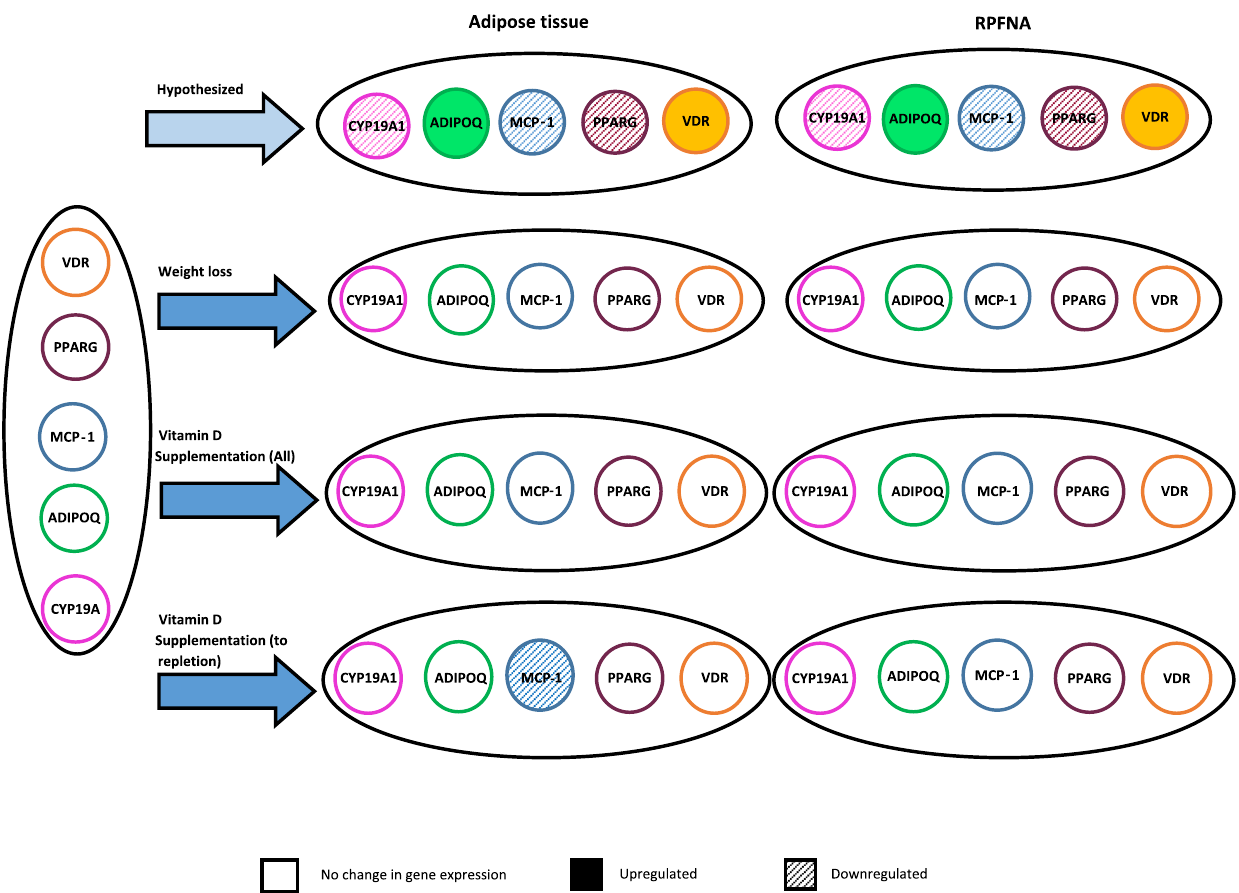
Fig. 1 Hypothesized and observed changes in gene expression according to treatment condition in vitamin D, diet and activity (ViDA)